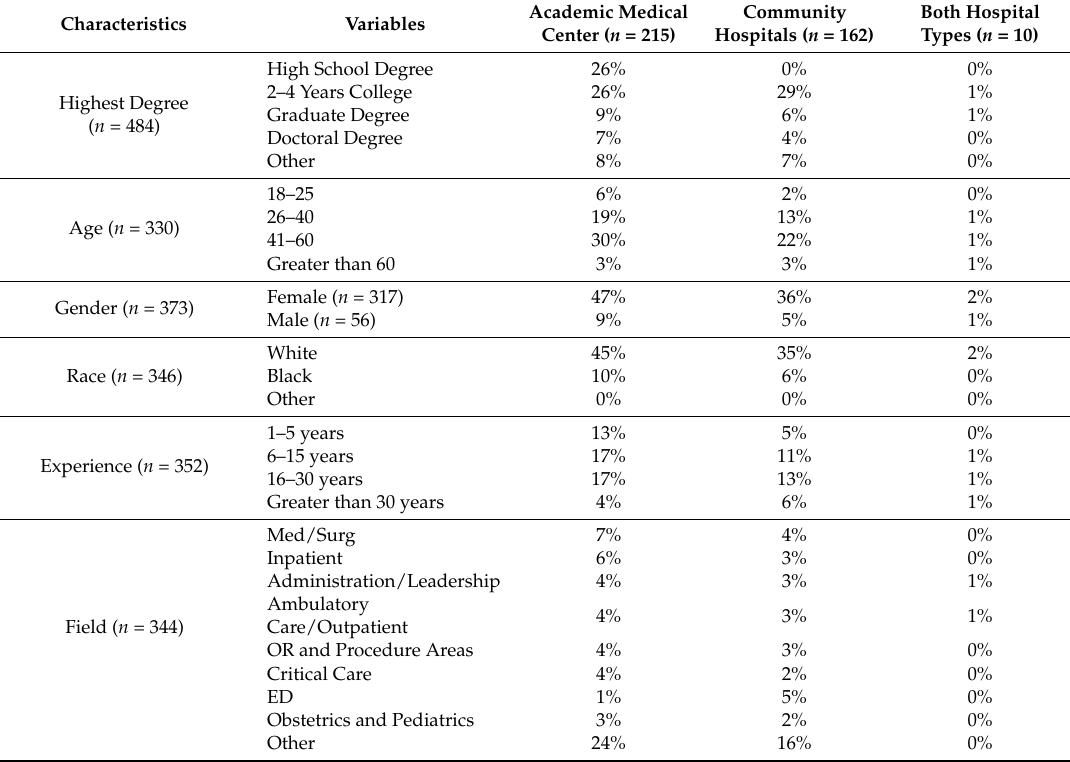
Table 1. Demographic characteristics by hospital